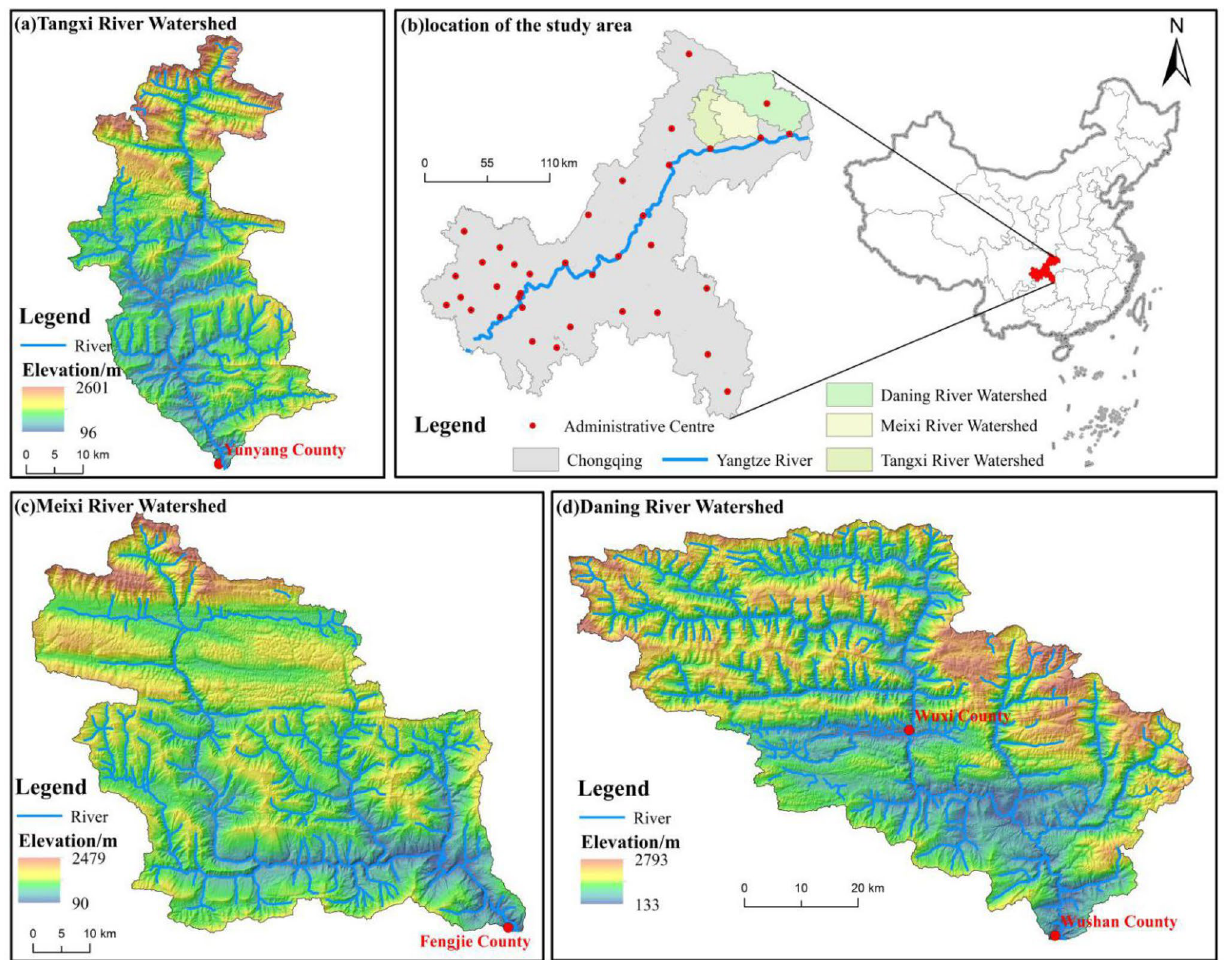
Figure 3. Location and topography of the study area in the TGRA. Maps were generated using ArcGIS 10.2 for Desktop (http:// www. esri. com/ sofwa re/